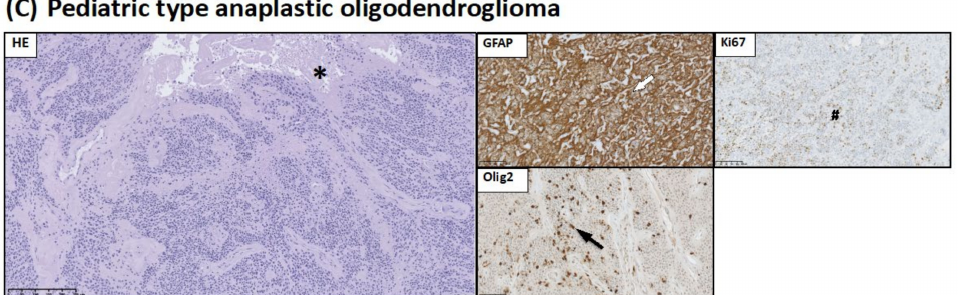
Figure 2. Histological and immunohistochemical staining of group 2 pediatric brain tumors: glioblastoma, pediatric- type oligodendroglioma, and pediatric-type anaplastic oligodendroglioma. HE staining as well as GFAP, Ki67, and Olig2 immunohistochemical staining were performed to visualize typical manifestations in these types of tumor tissue. ( A ) Glioblastoma: foci of micronecrosis in HE staining (*). GFAP immunoreactivity in neoplastic cells (white arrow). Olig2 immunoreactivity in neoplastic cells (black arrow). High Ki67 LI in tumor tissue (#). ( B ) Pediatric type oligodendroglioma: round neoplastic cells with a halo pattern in HE staining (*). GFAP immunoreactivity in some neoplastic cells and in parenchyma (white arrow). Olig2 immunoreactivity in neoplastic cells (black arrow). Low Ki67 LI in tumor tissue (#). ( C ) Pediatric type anaplastic oligodendroglioma: foci of necrosis in HE staining (*). GFAP immunoreactivity in neoplastic cells (white arrow). Olig2 immunoreactivity in neoplastic cells (black arrow). High Ki67 LI in tumor tissue (#). Preparations were scanned at original magnification 40 × , and digital magnification presented on the image is 10 × for HE and 5 × for immunohistochemical